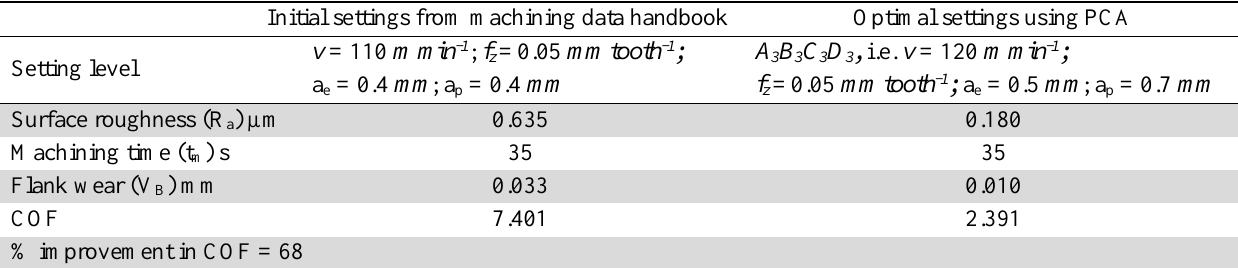
Results of initial and optimal settings Initial settings from machining data handbook Optimal settings using